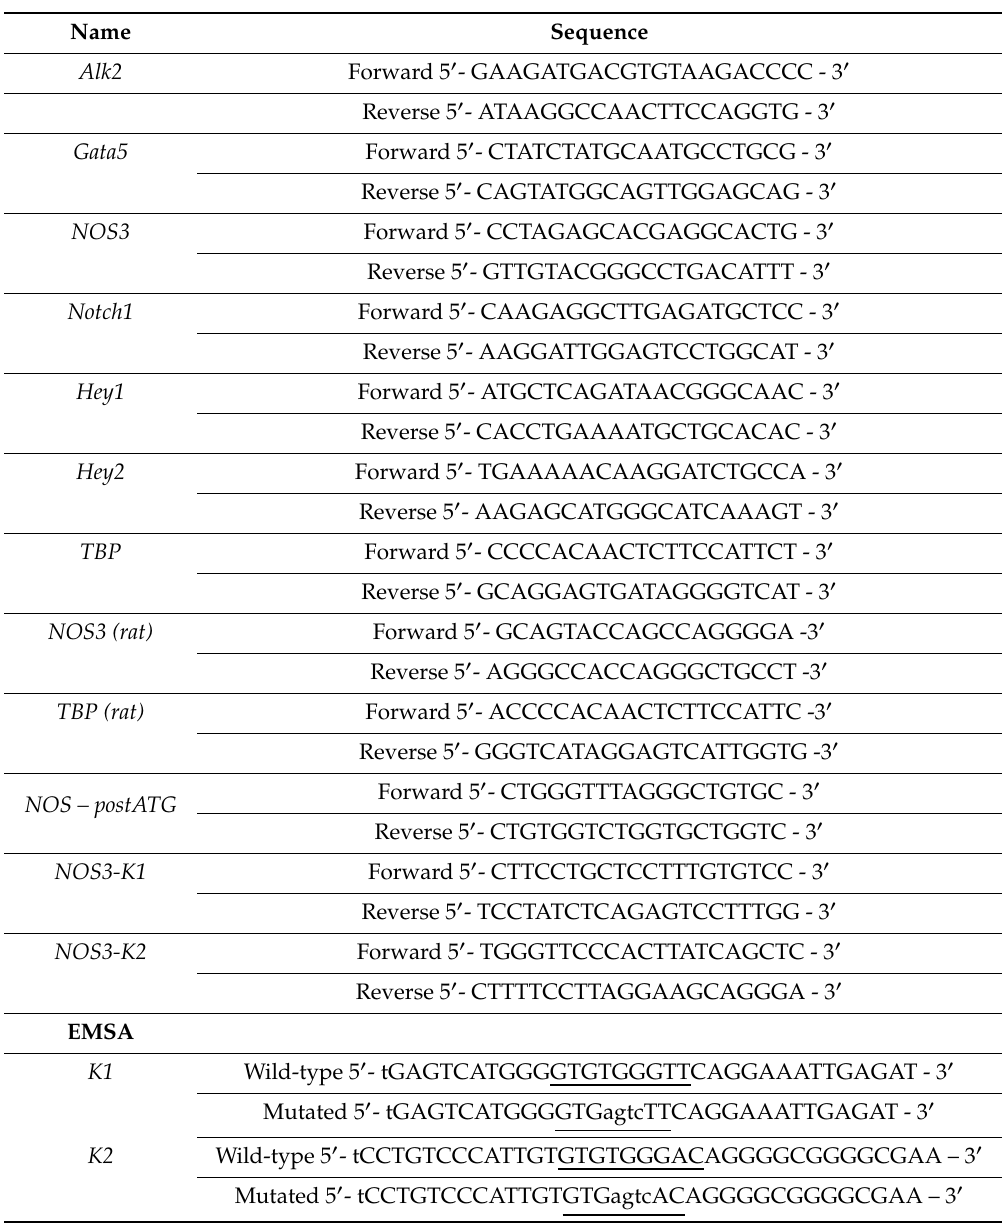
Table 1. Primers qPCR, ChIP and